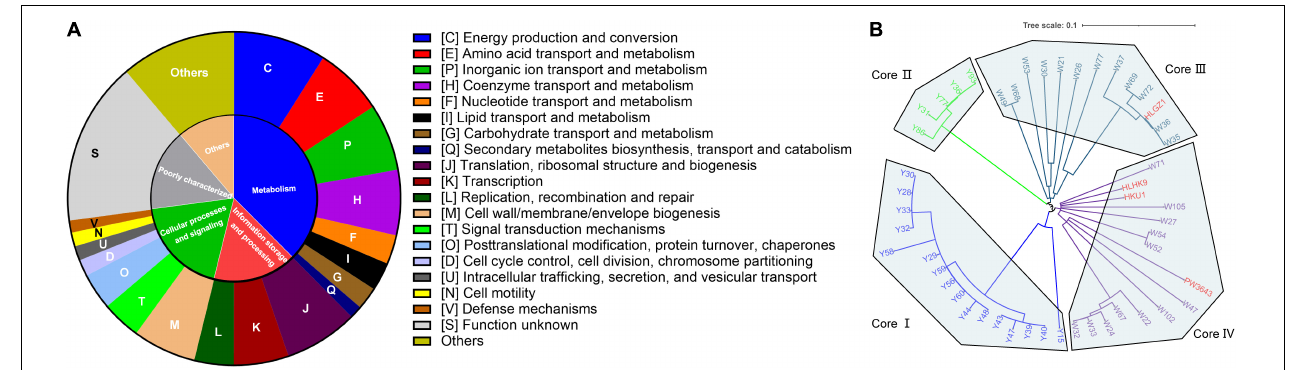
FIGURE 2 | Function annotation and phylogenetic tree of L. hongkongensis core genes. (A) COG Function categories of core genes. The annotation was conducted with eggNOG based on the COG database. (B) Phylogenetic tree of 49 L. hongkongensis strains based on amino acid sequences of core genes inferred with PhyloPhlAn 3.0.60. The genes can be grouped into eggNOG orthologous groups, but cannot be grouped into any COG function categories by eggNOG were labeled as “others.”